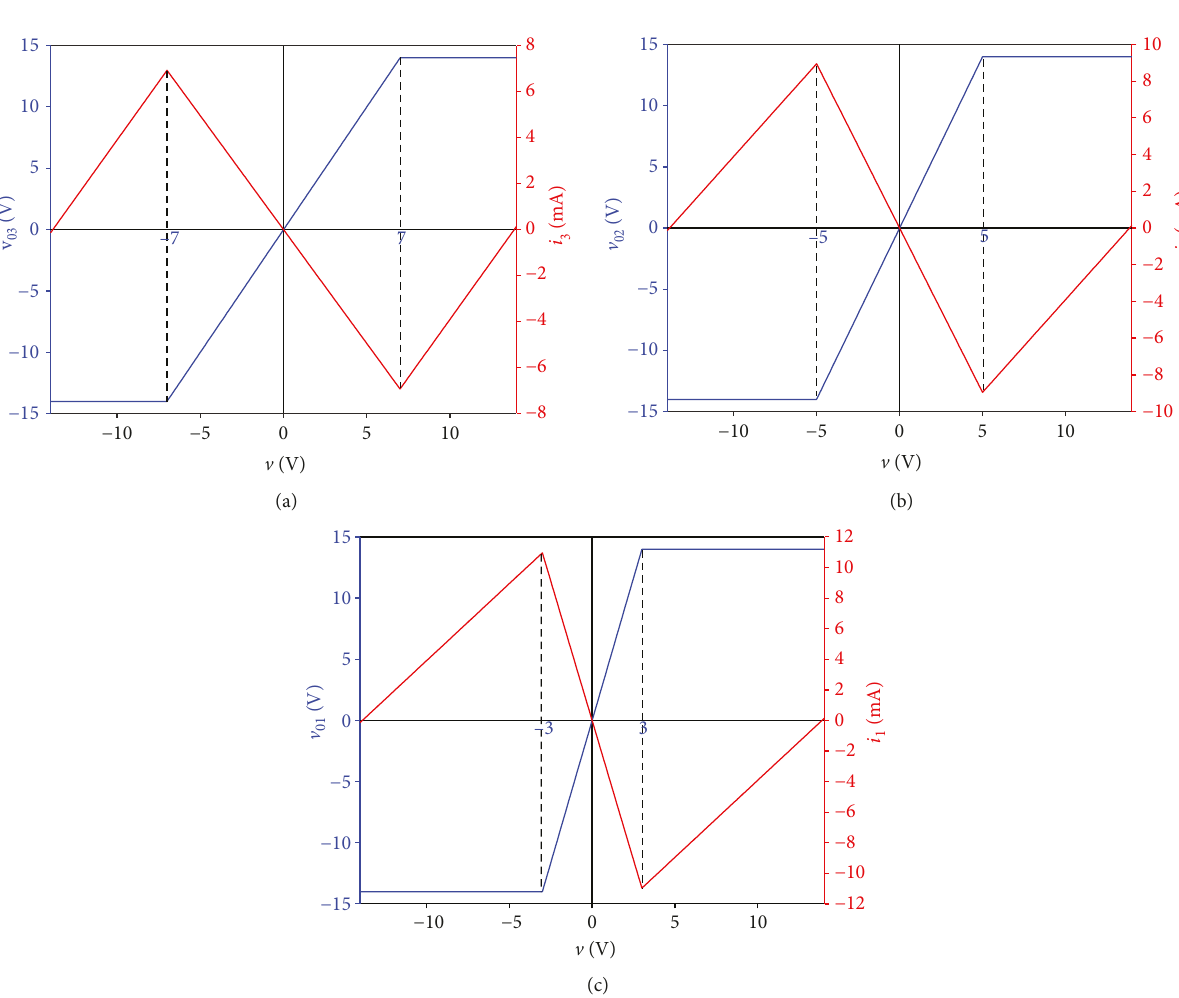
, i , and i ) and output voltages ( v 3 2 1 versus v , and (c) v versus v and i 2 01